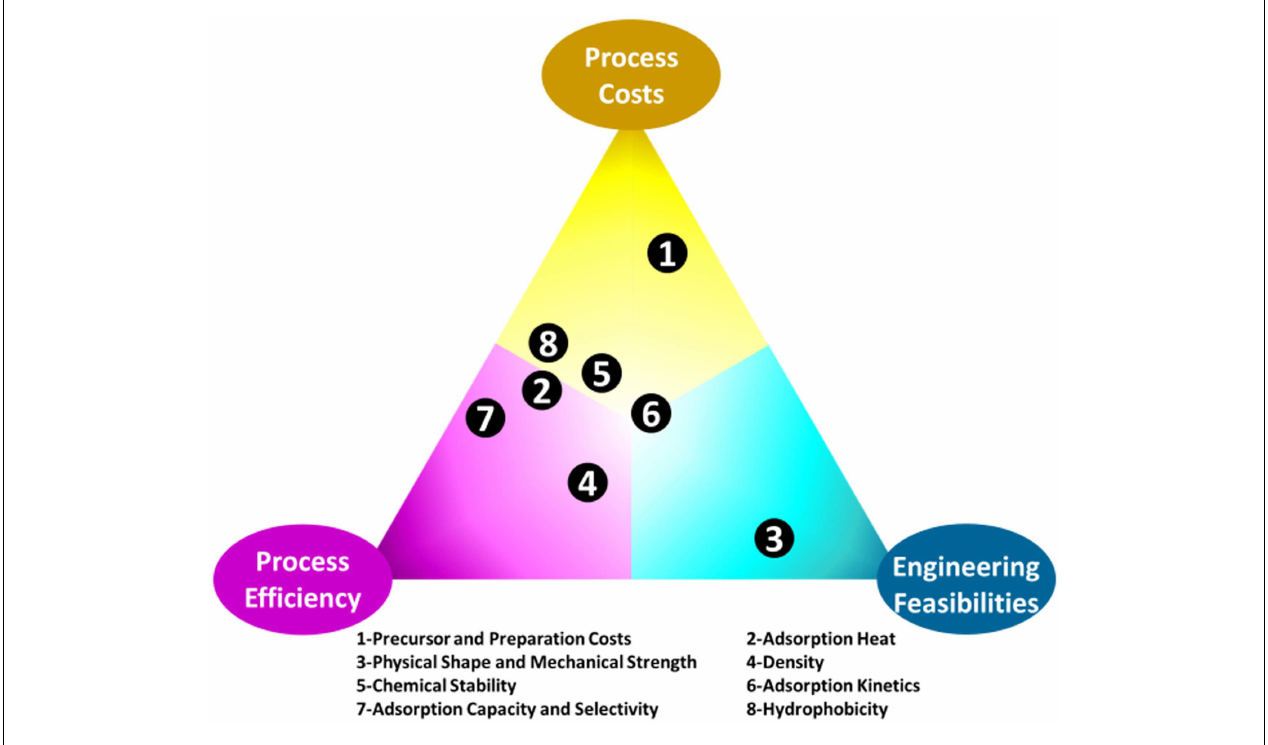
FIGURE 3 | Features of solid CO 2 adsorbents for industrial applications